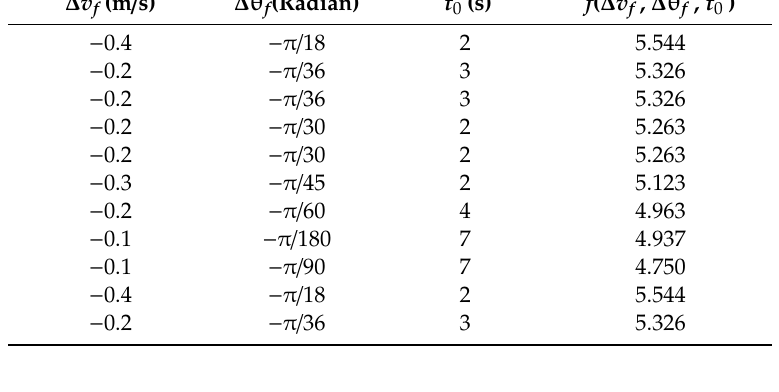
, ∆ θ , t and f (∆ v 0 f f ∆ v (m/s). f